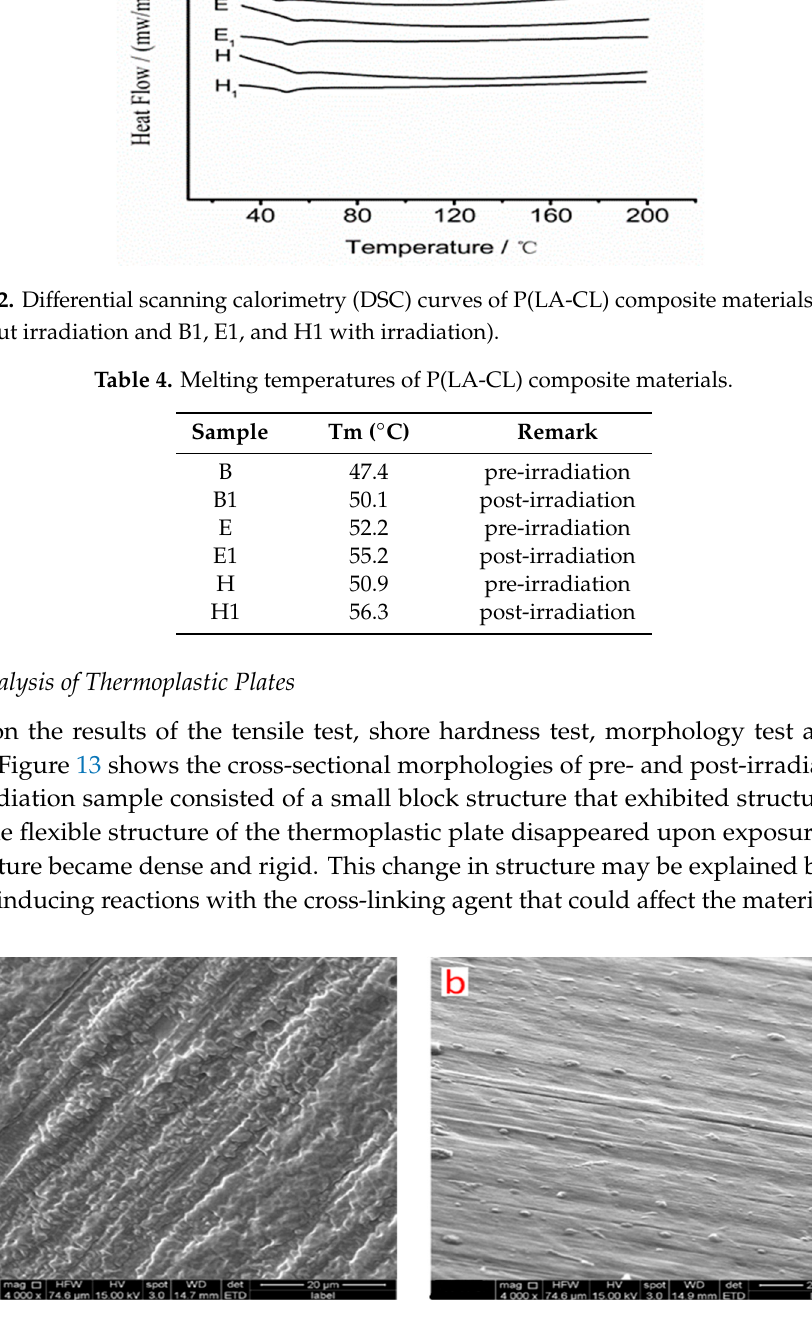
Figure 13. The cross-sectional morphologies of thermoplastic plates (a) pre-irradiation sample, (b) post-irradiation sample.